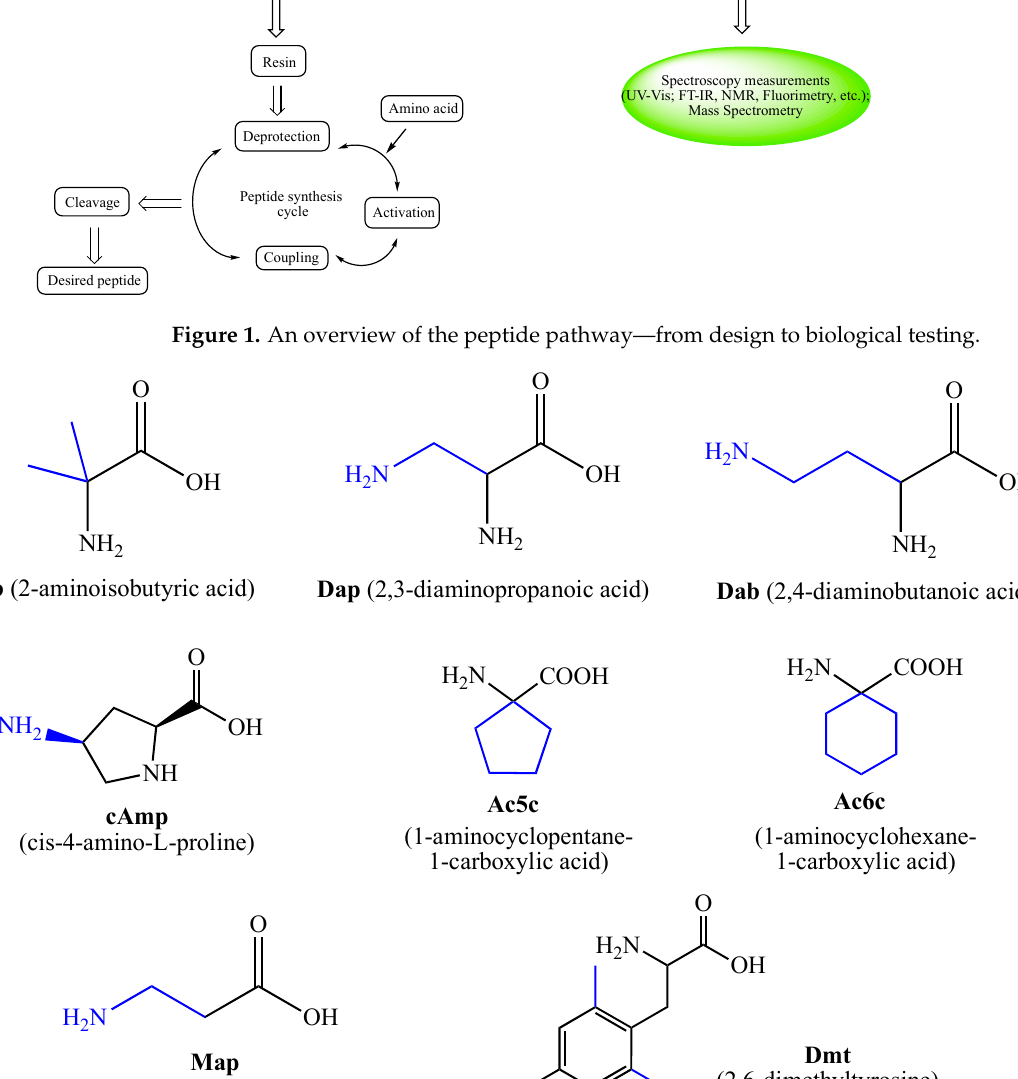
Figure 2. Some of the most used unnatural amino acids. In Table 1, the most active peptide hemorphin analogs, synthesized by our research team over the last five years, are Natural amino acids are replaced by non-natural and unusual amino acids, D-amino acids, α -aminophosphonic acids, and their derivatives with very different purposes: ob- taining a desired conformation of the peptide; obtaining the desired biological activity;